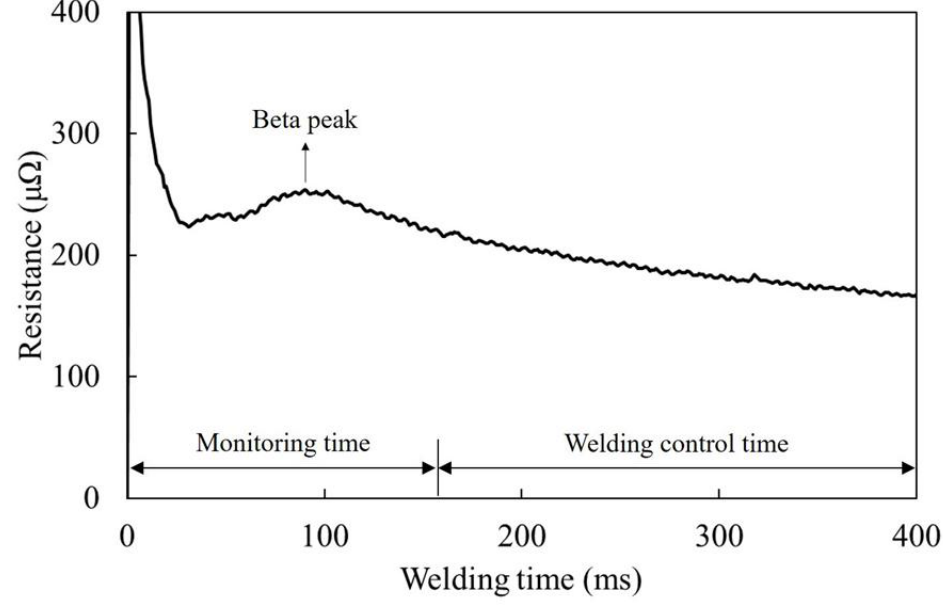
Figure 7. Relationship between the β -peak and the monitoring and welding control times.